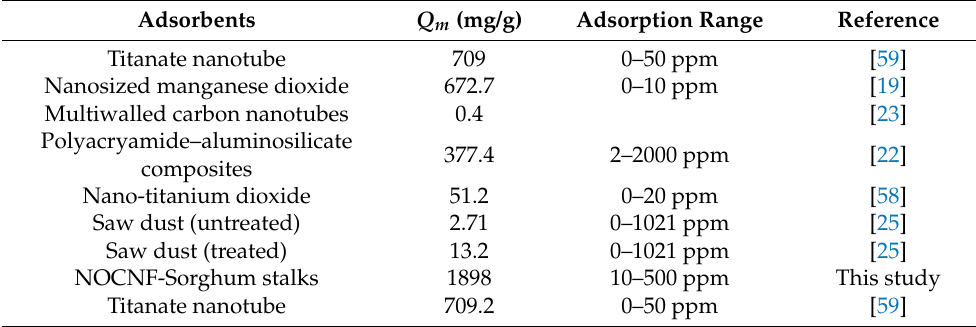
Table 3. The comparison of the Q m value for Tl(I) removal by various